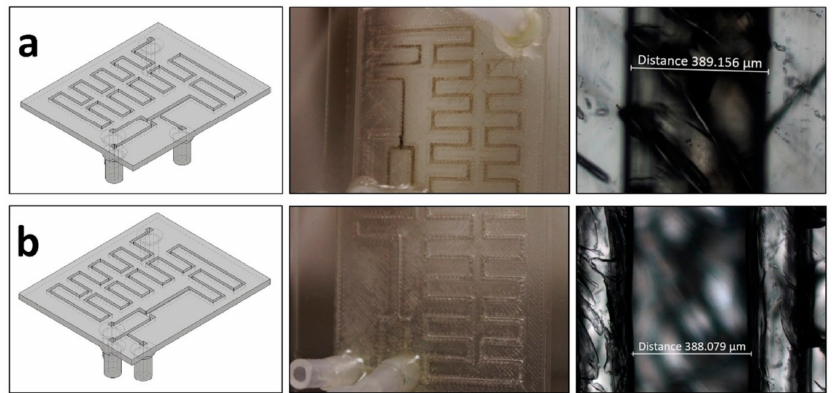
Figure 30. ( a ) ( Left ) Bottom view of the device used to synthesize nanoparticles with the mineral oil inlet put after the reactants. ( Center ) Top view photograph of the actual microfluidic chip showing fouling along the channels. ( Right ) Optical microscopy of the bottom of the channel showing a darker color due to fouling. ( b ) ( Left ) Same as ( a ) but this device presents the mineral oil inlet between the reactants flows. ( Center ) Same as ( a ) but this device presents no fouling along the channels. ( Right ) Same as ( a ) but this time there is no darker coloration inside the channel due to fouling. Reprinted from an open-access source [103].